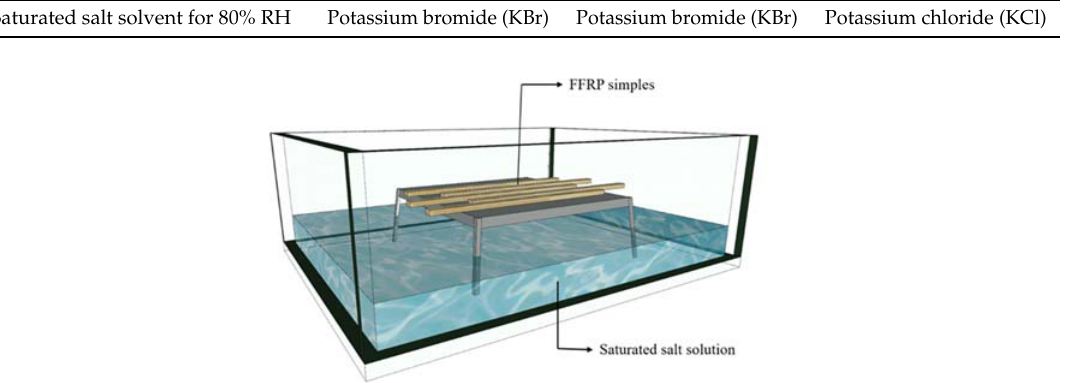
Table 1. Preparation of a hydrothermal environment with a saturated salt solution.